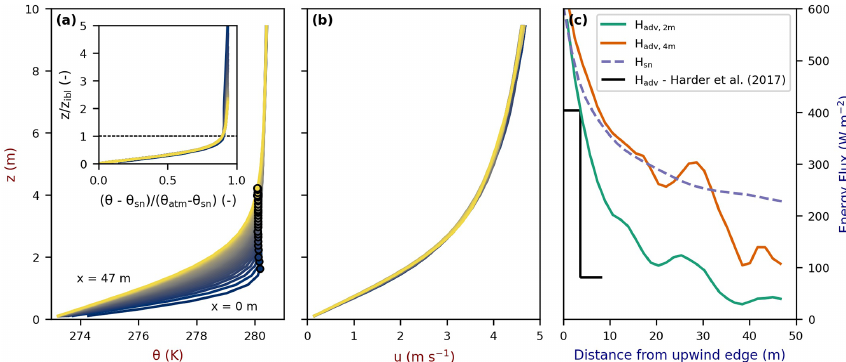
Figure 8. Time-averaged vertical temperature (a) and wind (b) profiles and horizontally advected sensible energy H adv at 2 and 4m integra- tion height and vertical sensible heat flux at the surface H sn (c) along the snow patch at y = 83m and x = 150m in the P30m simulation. The markers in the temperature profile resemble the IBL height, which is computed as the first value (seen from the bottom) of the gradient of the temperature with height below 0.1Km − 1 . The first two upwind grid cells and two downwind grid cells have been removed, as these are located in the transition region from bare ground to snow and vice versa. The labels with “ x = ” show the locations of vertical profile related to the downwind distance of the vertical profile from the leading edge, whereas the line color indicates the distance from the leading edge and goes from purple to red. In the inset graph, the vertical temperature profile has been normalized to the height of the IBL and the prescribed temperatures of the surface and atmosphere. The advected energy as a function of distance from the leading edge is based on Eq.